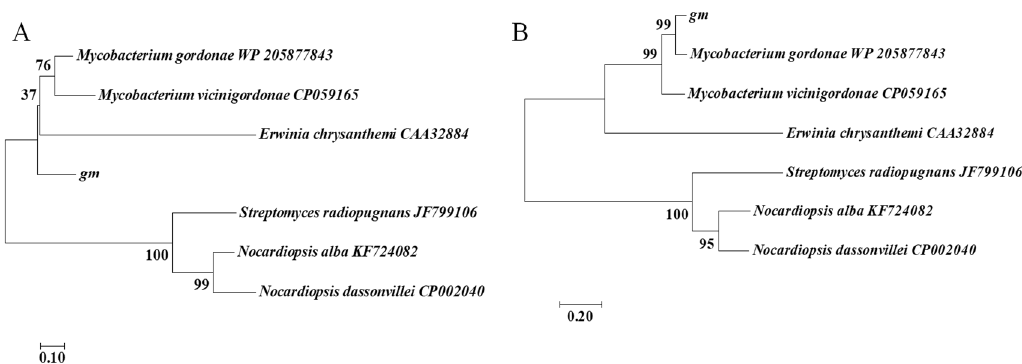
Figure 1. ( A ) Phylogenetic tree analysis of nucleotide sequences of Mycobacterium gordonae L-asparaginase. ( B ) Phylogenetic tree analysis of amino acid sequences in Mycobacterium gordonae L-asparaginase.